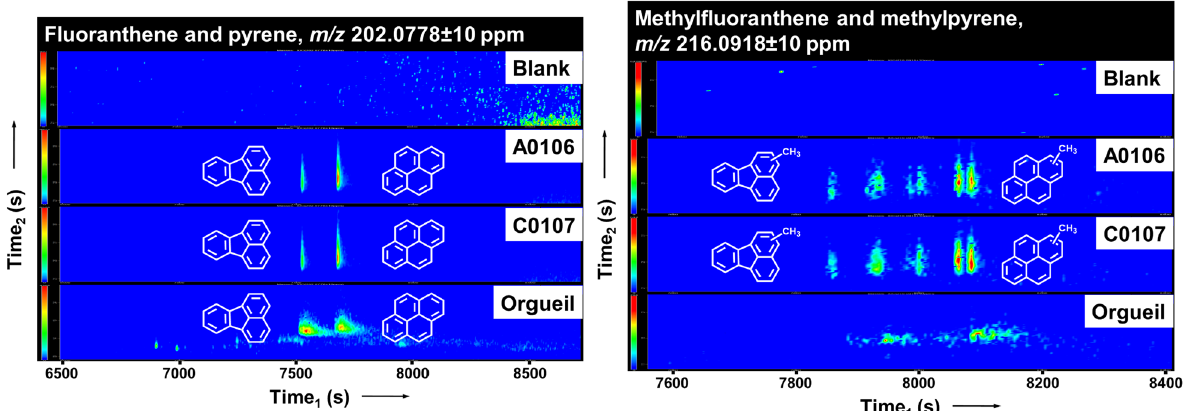
Fig. 4 GC GC–HRMS analysis of fluoranthene and pyrene characterized by m/z 202.0778 10 ppm, and methylfluoranthene and methylpyrene × ± characterized by m/z 216.0918 10 ppm from the baked serpentine blank, Ryugu samples A0106, C0107, and the Orgueil meteorite DCM extracts. ± The insert color scales represent relative peak intensities, where colder colors (blue toward green) indicate lower values and warmer colors (yellow to red) higher values. The timeframe for the second dimension (Time 2 ) in each chromatogram of fluoranthene and pyrene goes from 0.8 to 2.9 s (Start: 2%; Stop: 80%, Factor: 1.5), and for the isomers of methylfluoranthene and methylpyrene from 1.0 to 2.5 s (Start: 10%; Stop: 60%, Factor: 1). Isomers were not explicitly identified due to the use of a mixed isomer